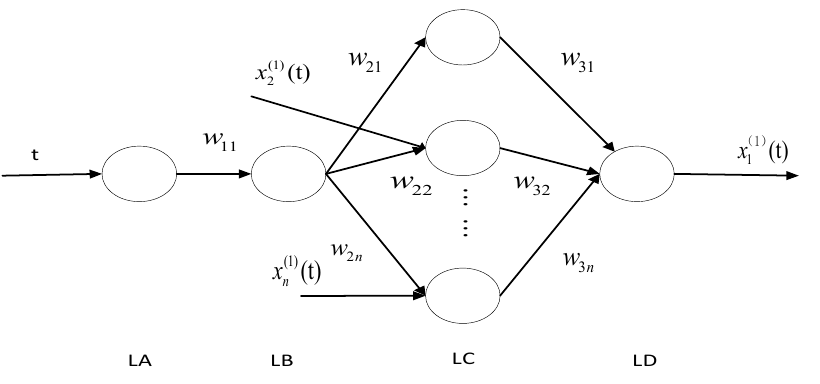
Figure 2. Neural network topology.